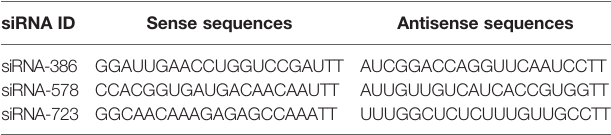
TABLE 1 | Design of the potential three siRNA sequences targeting EgGLUT1- ss. Gene.